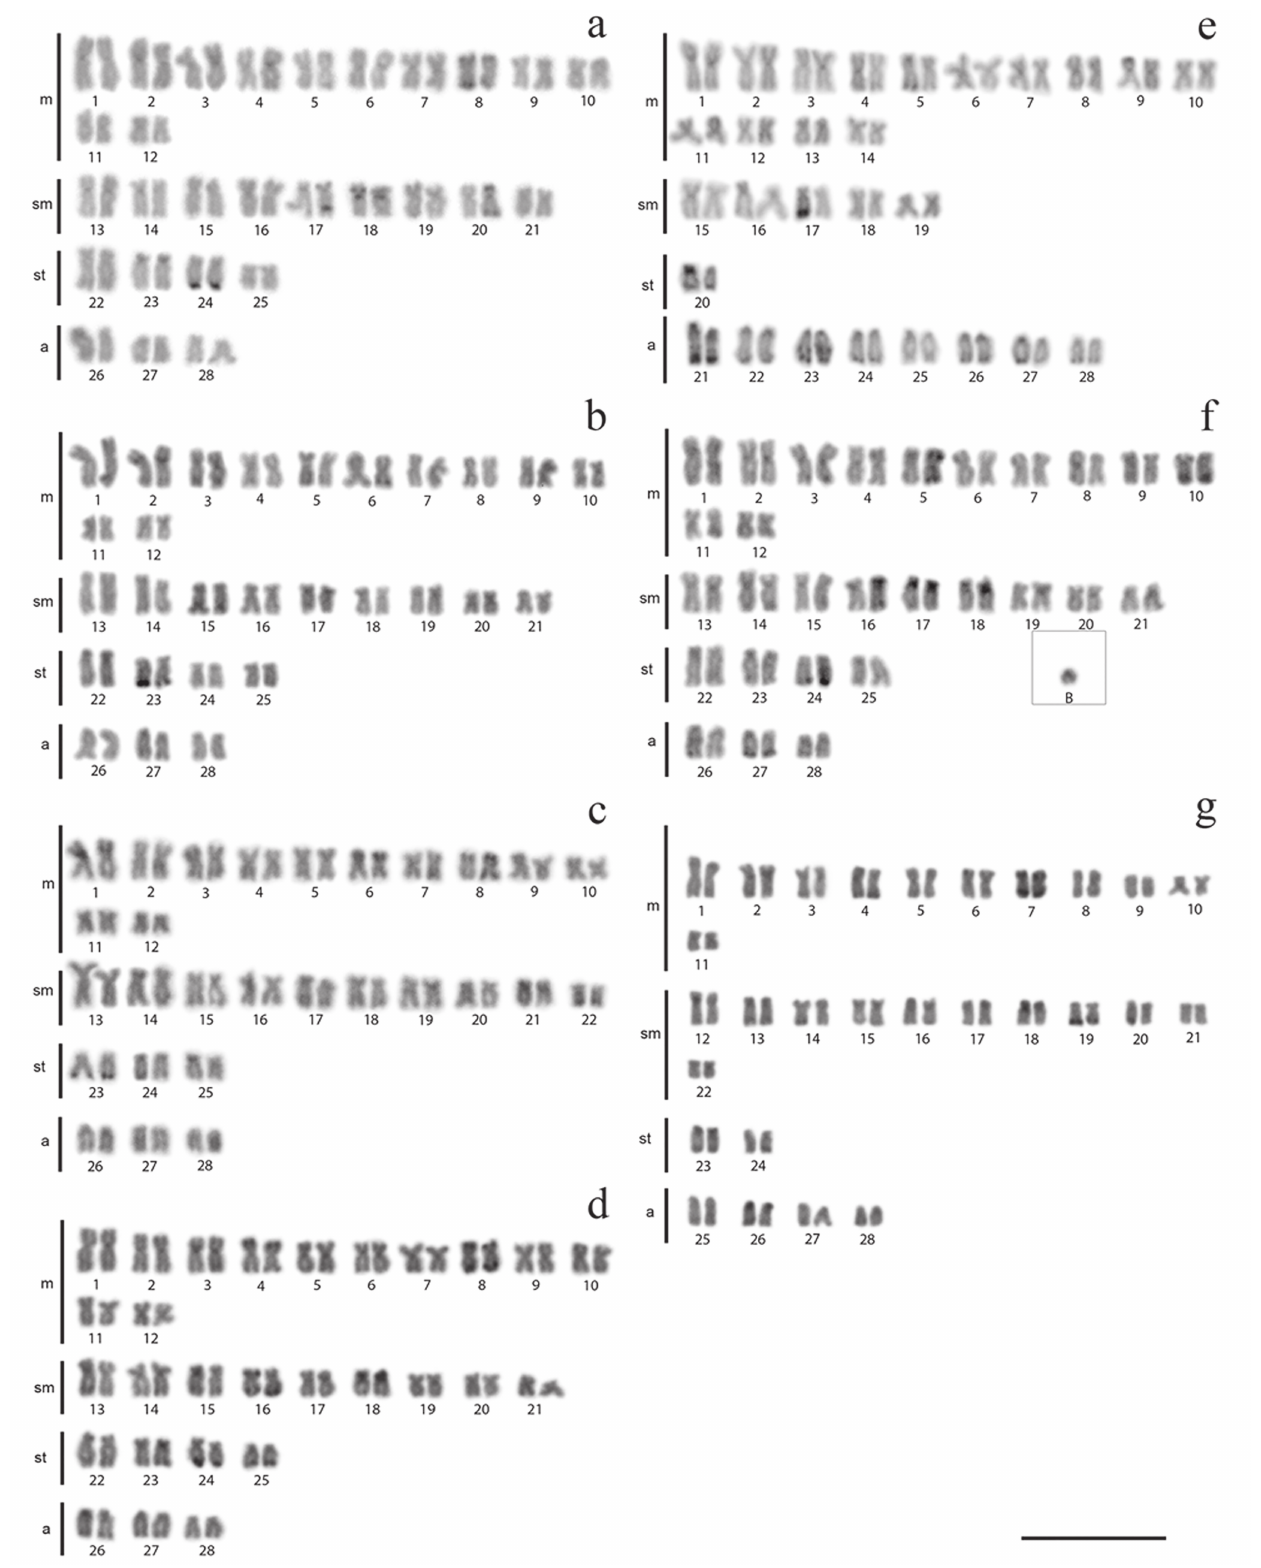
Fig. 2. Karyotypes arranged from C-banded chromosomes. a. Pimelodus absconditus ; b. Pimelodus britskii ; c. Pimelodus maculatus ; d. Pimelodus microstoma ; e. Pimelodus mysteriosus ; f. Pimelodus ortmanni ; g. Pimelodus paranaensis . B chromosomes in the boxes. Scales bar = 10